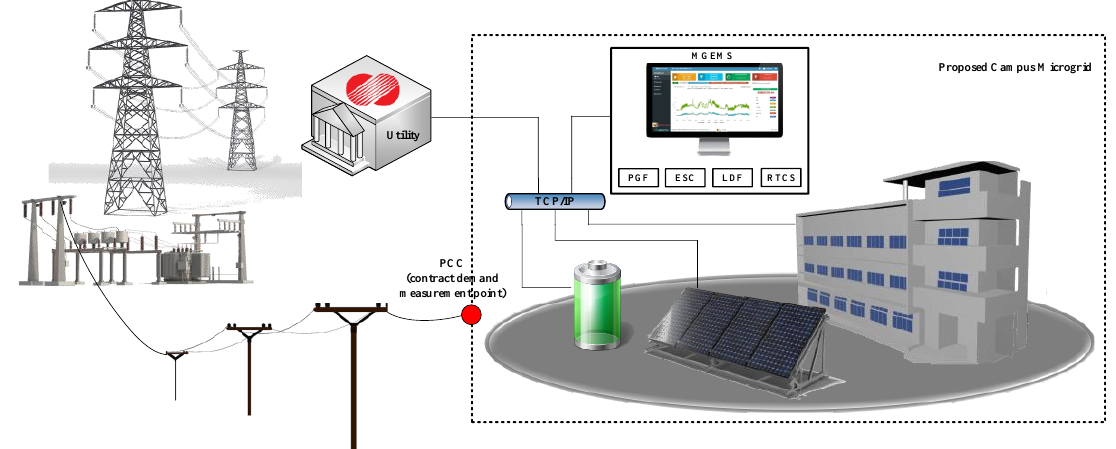
Figure 4. Schematics of a campus microgrid model.